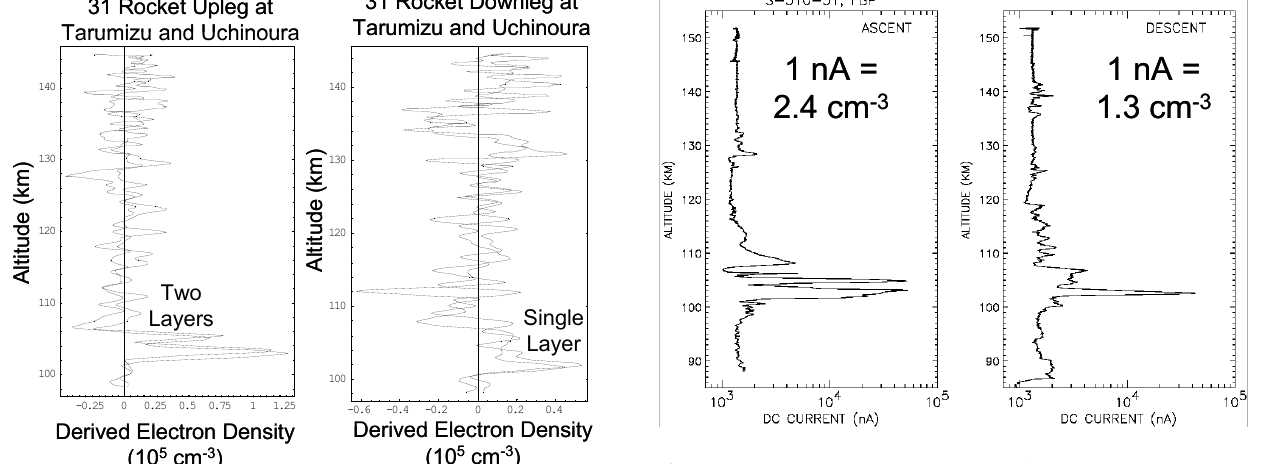
Figure 8. Fixed bias probe measurements of electron density. Fig. 8. Fixed bias probe measurements of electron Table I Comparison of Plasma Probe and Radio Beacon Derived Peak Densities Ratio